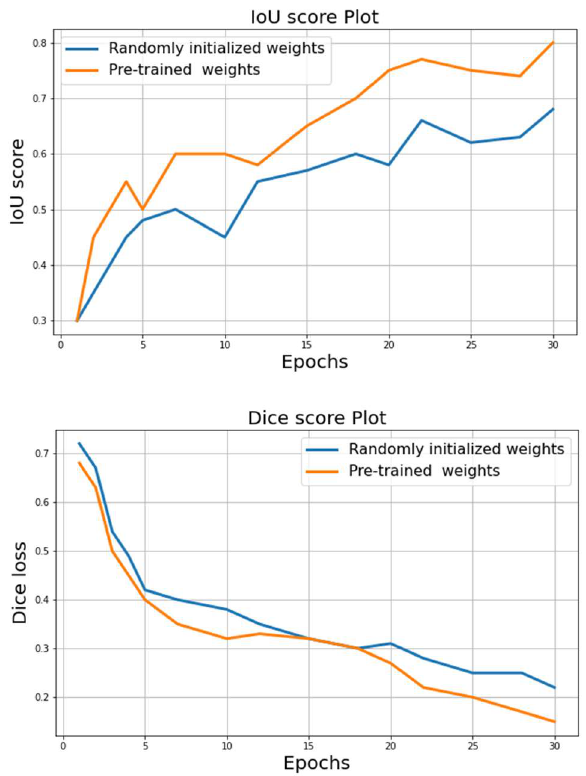
Figure 4. Examples of misclassification by the model.